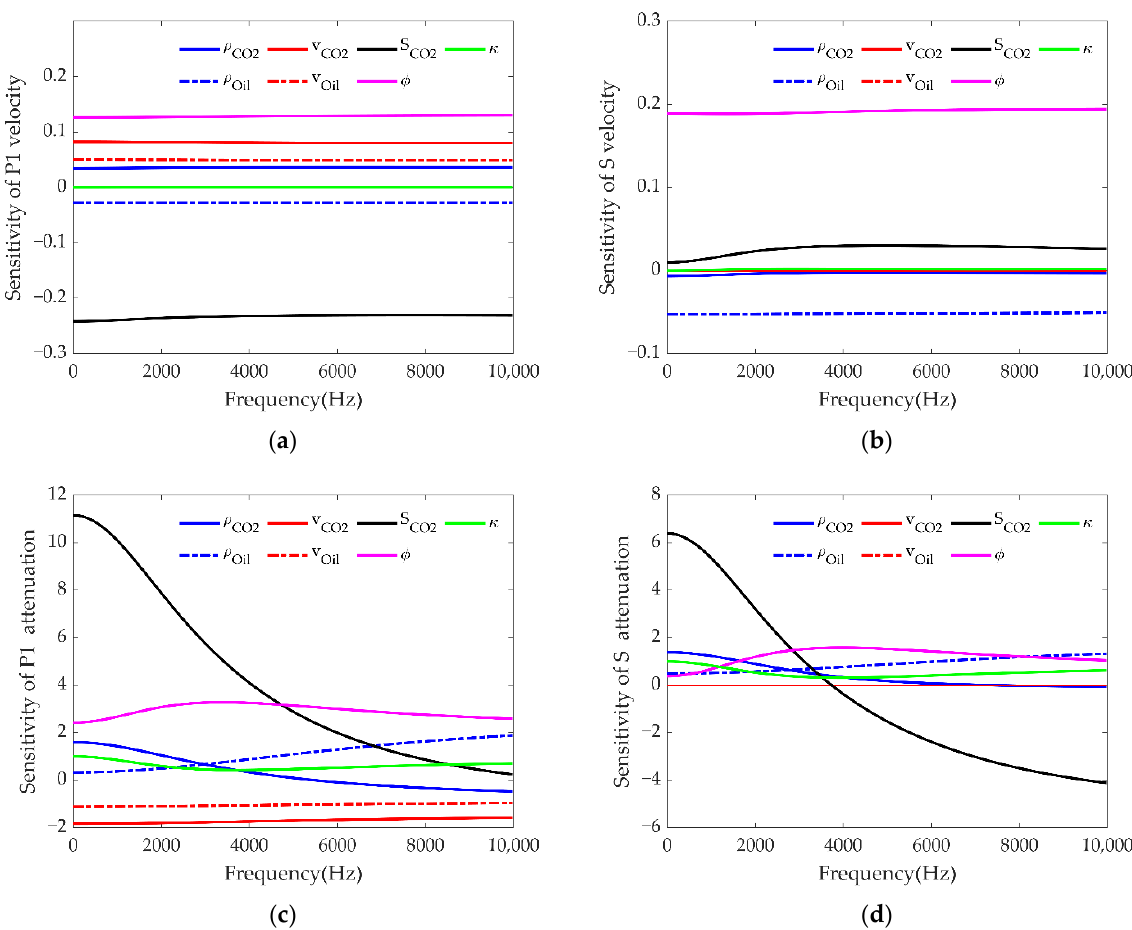
Figure 4. The sensitivities of velocities and attenuations of P1 and S to different parameters, including CO 2 density ( ρ CO 2 ) and velocity (v CO 2 ), live oil density ( ρ Oil ) and velocity (v Oil ), CO 2 saturation ( S CO2 ), porosity ( φ ), and permeability ( κ ): ( a ) P1 velocity; ( b ) S velocity; ( c ) P1 attenuation; ( d ) S attenuation.